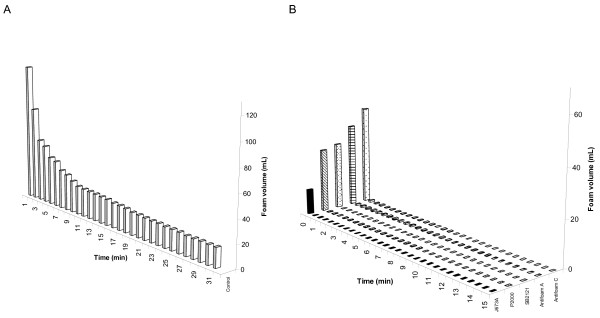
Antifoams affect foam volume as determined by a Bartsch test. The antifoams used in Figure 1, were tested for their foam destruction capacity. Foam volume was recorded for 0% v/v antifoam (A) and 0.001% of each antifoam (B) in BMMY medium over a 15 min time course (n = 5).